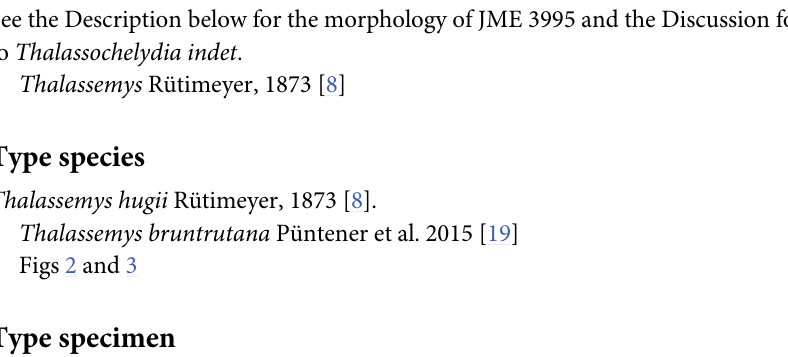
pace (Fig 1) from Late Jurassic (early Tithonian) Altmu¨hltal Formation of Birkhof, Bavaria,